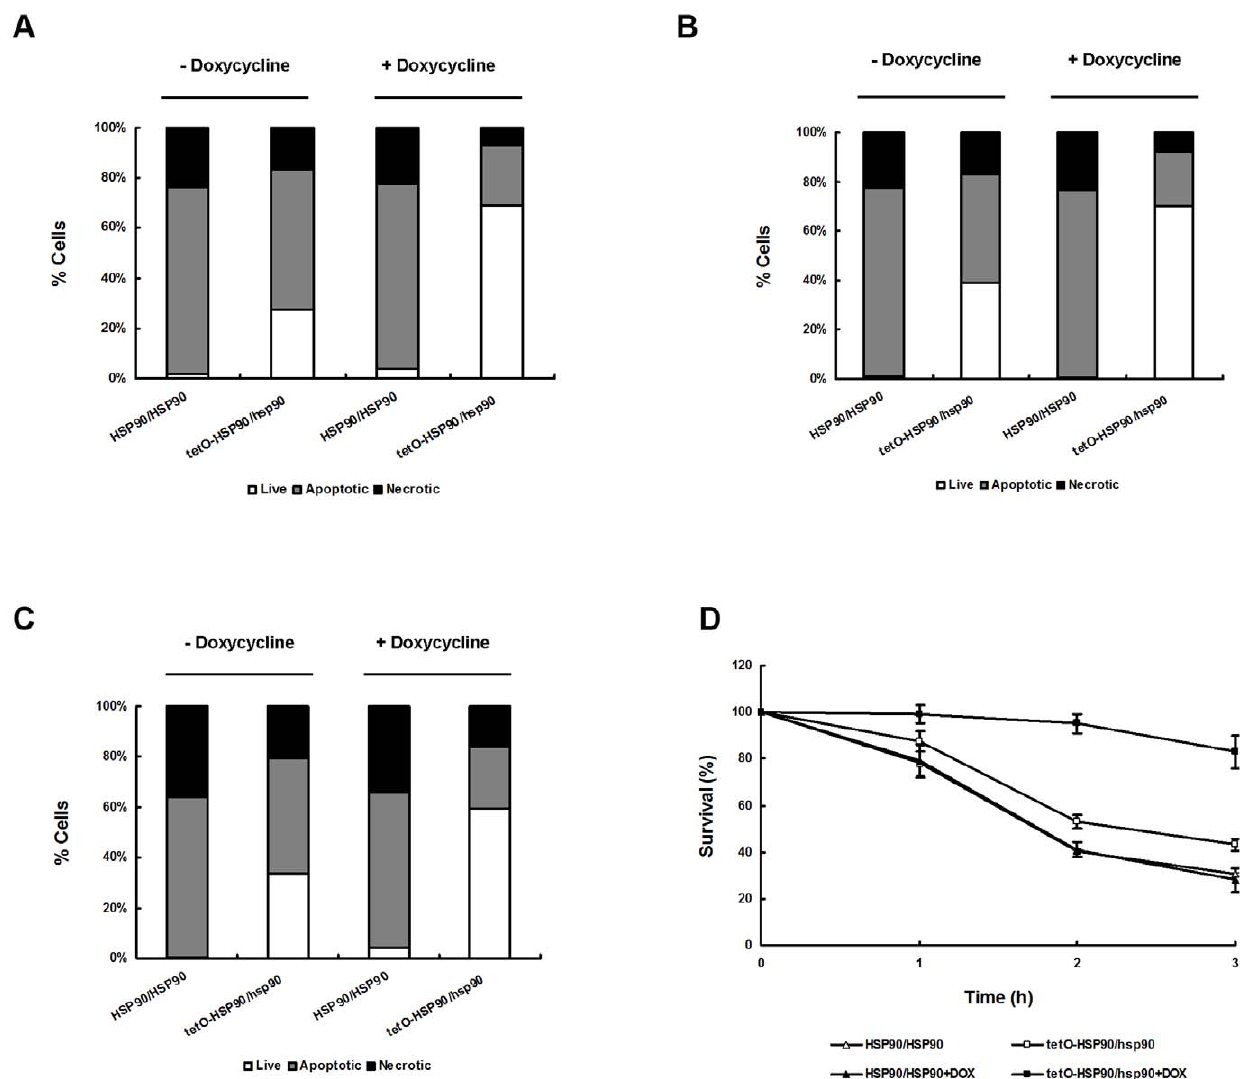
Figure 2. The impact of compromised Hsp90 on the fate of C.albicans cells after apoptotic stimuli. The number of live cells (white bars), apoptotic cells (grey bars) and necrotic cells (black bars) were assessed after apoptotic stimulus treatment for 3 h in the absence or presence of 20 m g/ml DOX. (A) Cells treated with 5 mM H 2 O 2 . (B) Cells treated with 60 mM AA. (C) Cells treated with 2 m g/ml AMB. (D) After 1.25 mM H 2 O 2 treatment for 3 h, overall viability was determined by clonogentic assays. Data are shown as mean 6 SD from three independent experiments.